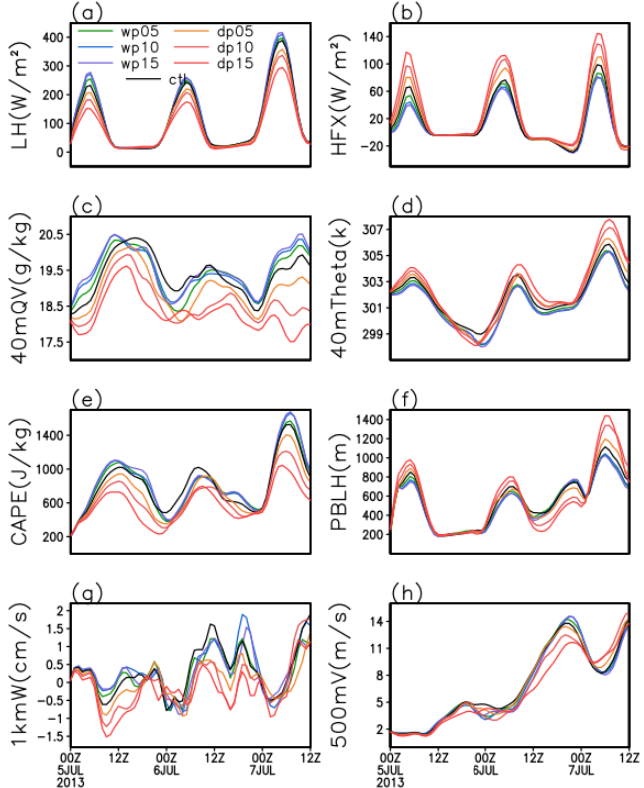
Figure 10. Area-averaged time series of thermal dynamical conditions near surface. ( a ) Surface latent heat fluxes (units: W ⋅ m −2 ); ( b ) sensible heat fluxes (units: W ⋅ m −2 ); ( c ) 40-m qv (units: g ⋅ kg −1 ); ( d ) 40-m heat fluxes (units: W ¨ m ´ 2 ); ( b ) sensible heat fluxes (units: W ¨ m ´ 2 ); ( c ) 40-m qv (units: g ¨ kg ´ 1 ); ( d ) 40-m potential temperature (units: k); ( e ) CAPE (units: J ⋅ kg −1 ); ( f ) PBL height (units: m); ( g ) 1-km vertical potential temperature (units: k); ( e ) CAPE (units: J ¨ kg ´ 1 ); ( f ) PBL height (units: m); ( g ) 1-km vertical velocities (units: 10 −1 m ⋅ s −1 ) and ( h ) 500-m meridional velocities (units: m ⋅ s −1 ). velocities (units: 10 ´ 1 m ¨ s ´ 1 ) and ( h ) 500-m meridional velocities (units: m ¨ s ´ 1